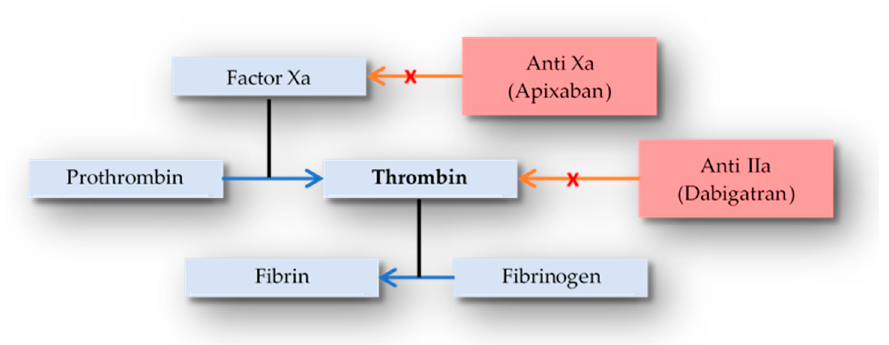
Figure 2. DOAC’s mechanism of Figure 2. Warfarin mechanism of action. Figure 2. Warfarin mechanism of action.